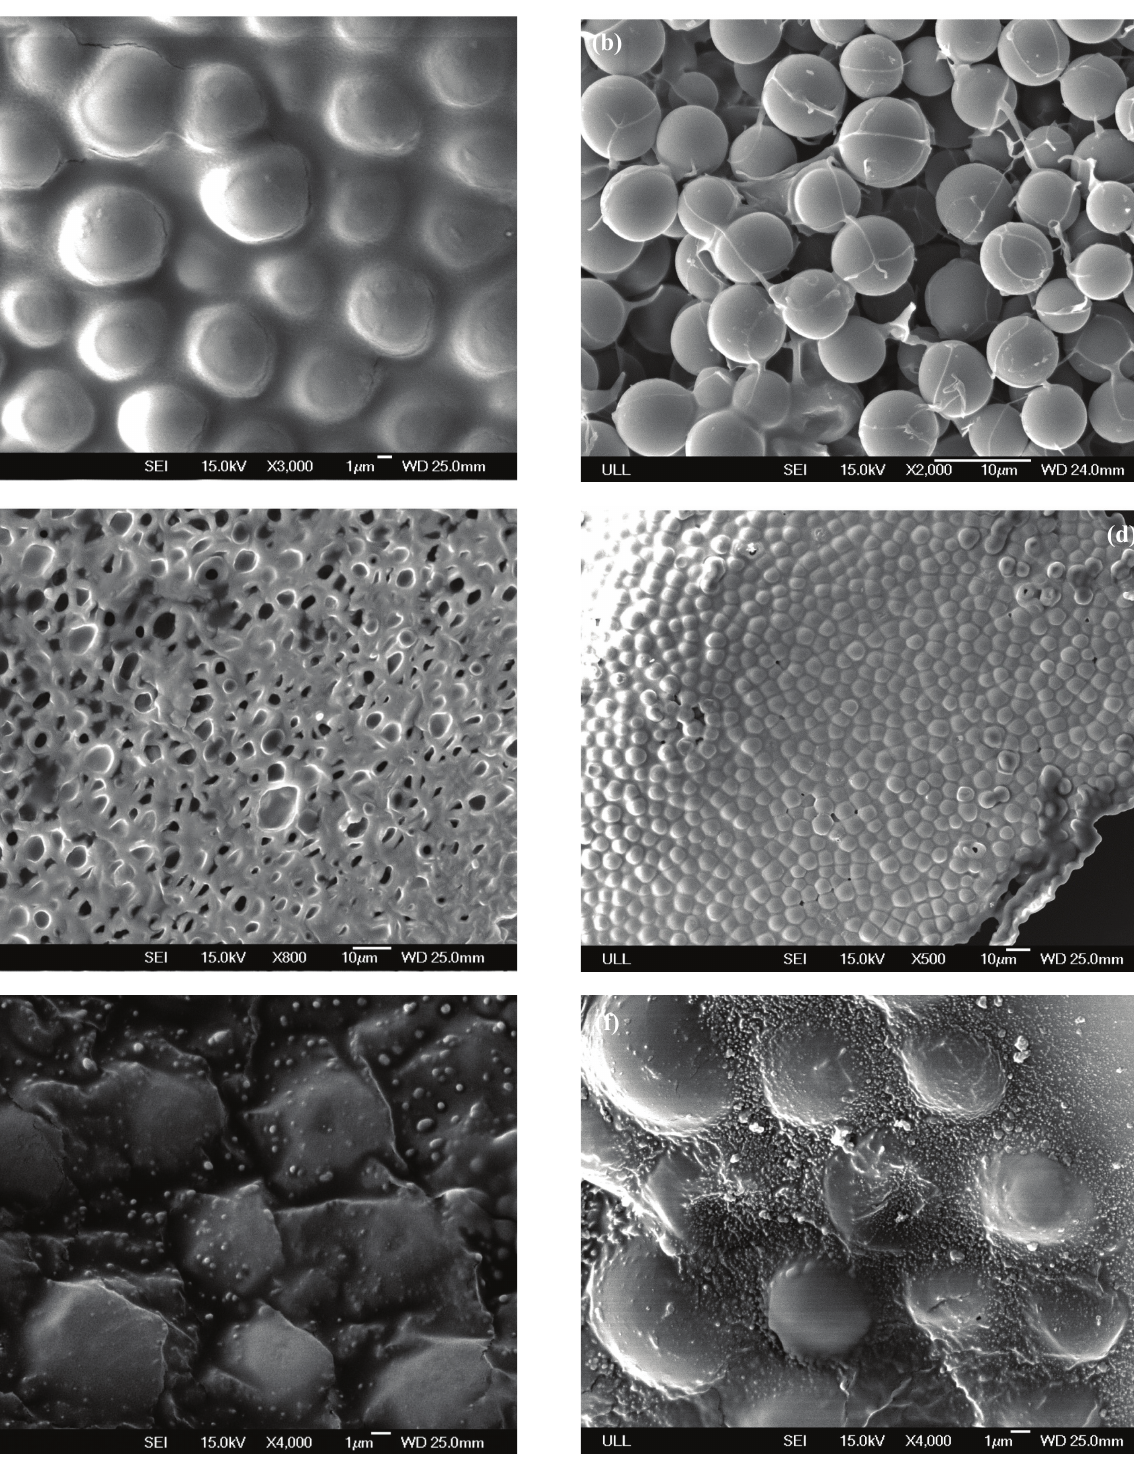
Fig. 2 – (a) SEM image of freeze-dried cells collected after repeated fed-batch experiment. Cells are seen encased in the EPS con- nective matter. (b) SEM image of freeze-dried, zymolyase-treated cells collected after repeated fed-batch experiment. Cells are stripped of the EPS connective matter. (c) SEM image of freeze-dried, acid-bath-treated cells collected after repeated fed-batch experiment showing EPS remaining after cell digestion. (d) SEM image freeze-dried, boiling-water-treated cells collected after repeated fed-batch experiment showing EPS remaining intact. (e) SEM image of freeze-dried cells mixed with THF. (f) SEM image of freeze-dried cells mixed with